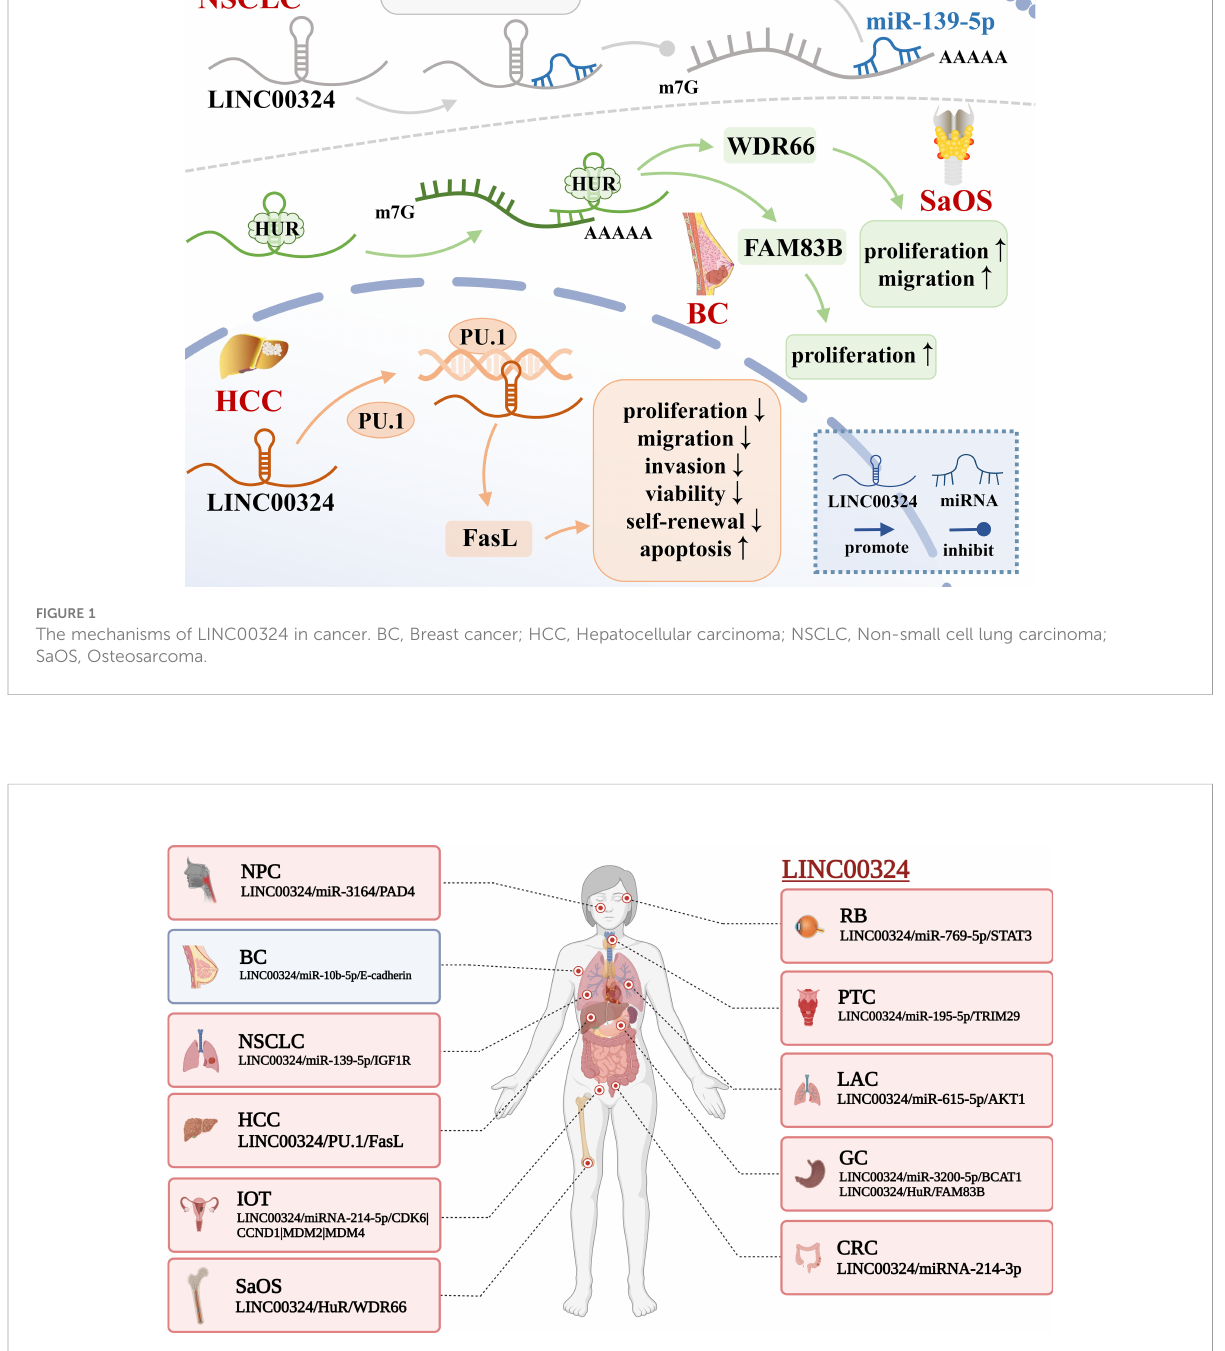
FIGURE 2 Effect of LINC00324 on cancer development. Red represents the mechanism of promoting cancer, and blue represents the mechanism of inhibiting cancer. BC, Breast cancer; CRC, Colorectal cancer; GC, Gastric cancer; HCC, Hepatocellular carcinoma; IOT, Immature ovarian teratocarcinoma; LAC, Lung adenocarcinoma; NPC, Nasopharyngeal carcinoma; NSCLC, Non-small cell lung carcinoma; PTC, Papillary thyroid cancer; RB, Retinoblastoma; SaOS, Osteosarcoma. (created by